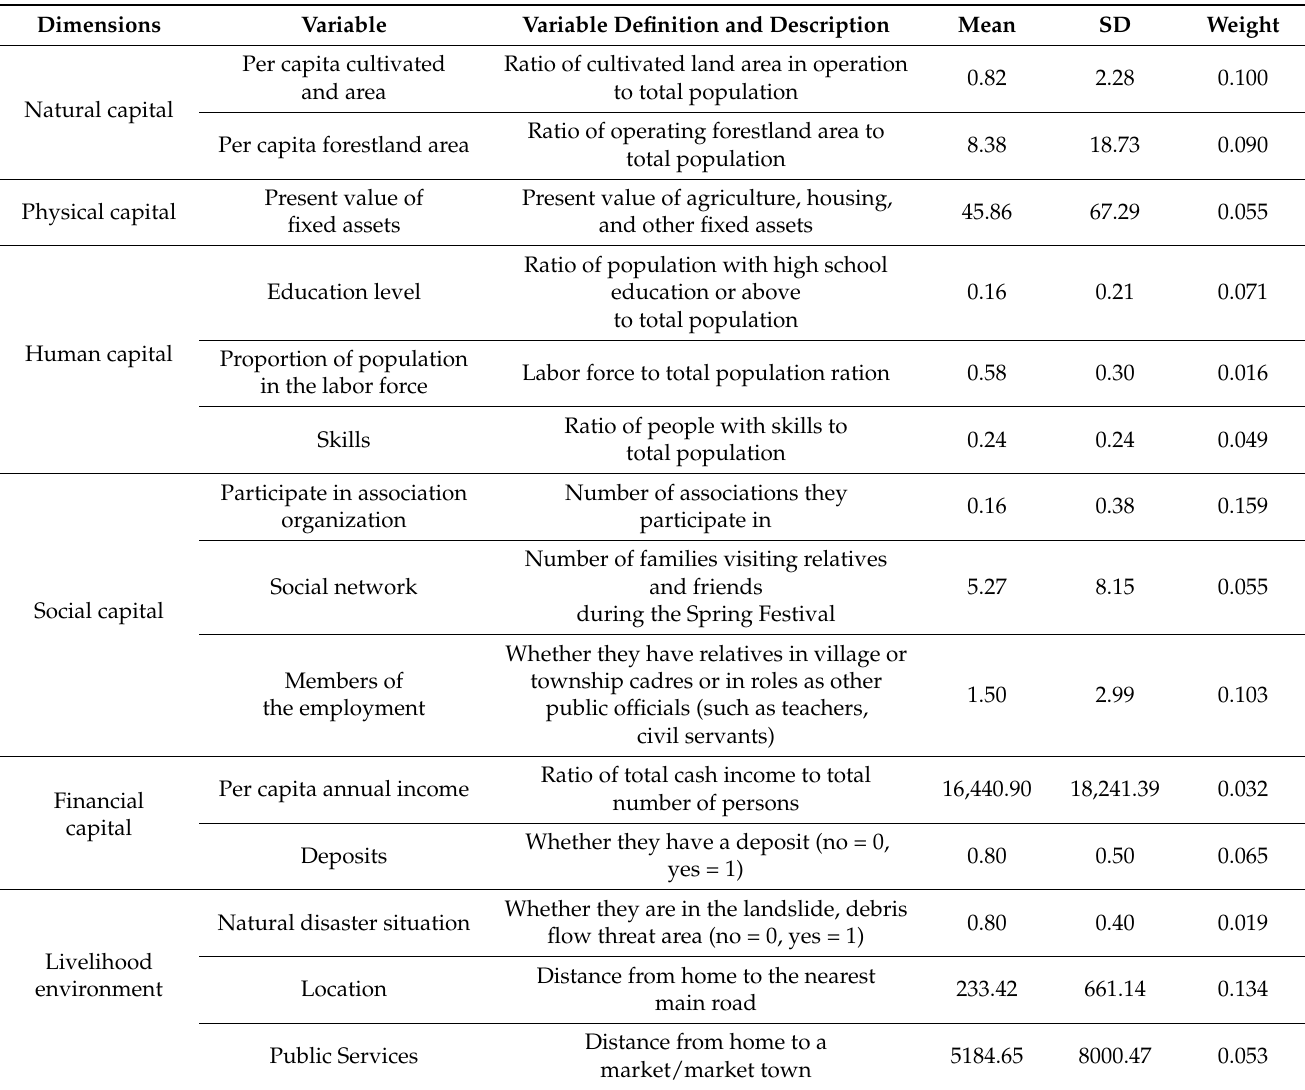
Table 2. Evaluation index system of peasant households’